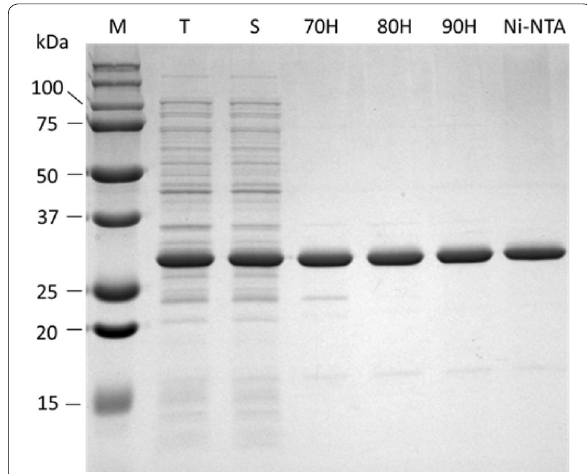
Fig. 2 SDS-PAGE analysis of recombinant enzyme expression in E. coli BL21 (DE3) and purification of AfPase. M, protein marker; T, total cell lysate of recombinant E. coli cells; S, the supernatant of cell lysate; 70H, purified AfPase after heat treatment of cell supernatant at 70 °C for 20 min; 80H, purified AfPase after heat treatment of cell supernatant at 80 °C for 20 min; 90H, purified AfPase after heat treatment of cell supernatant at 90 °C for 20 min; Ni–NTA,